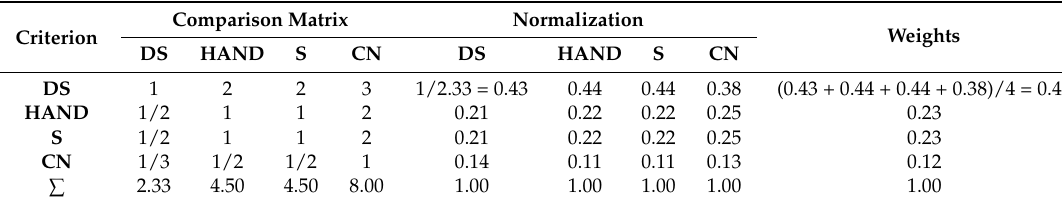
Table 8. Procedure for weights calculation for a sample